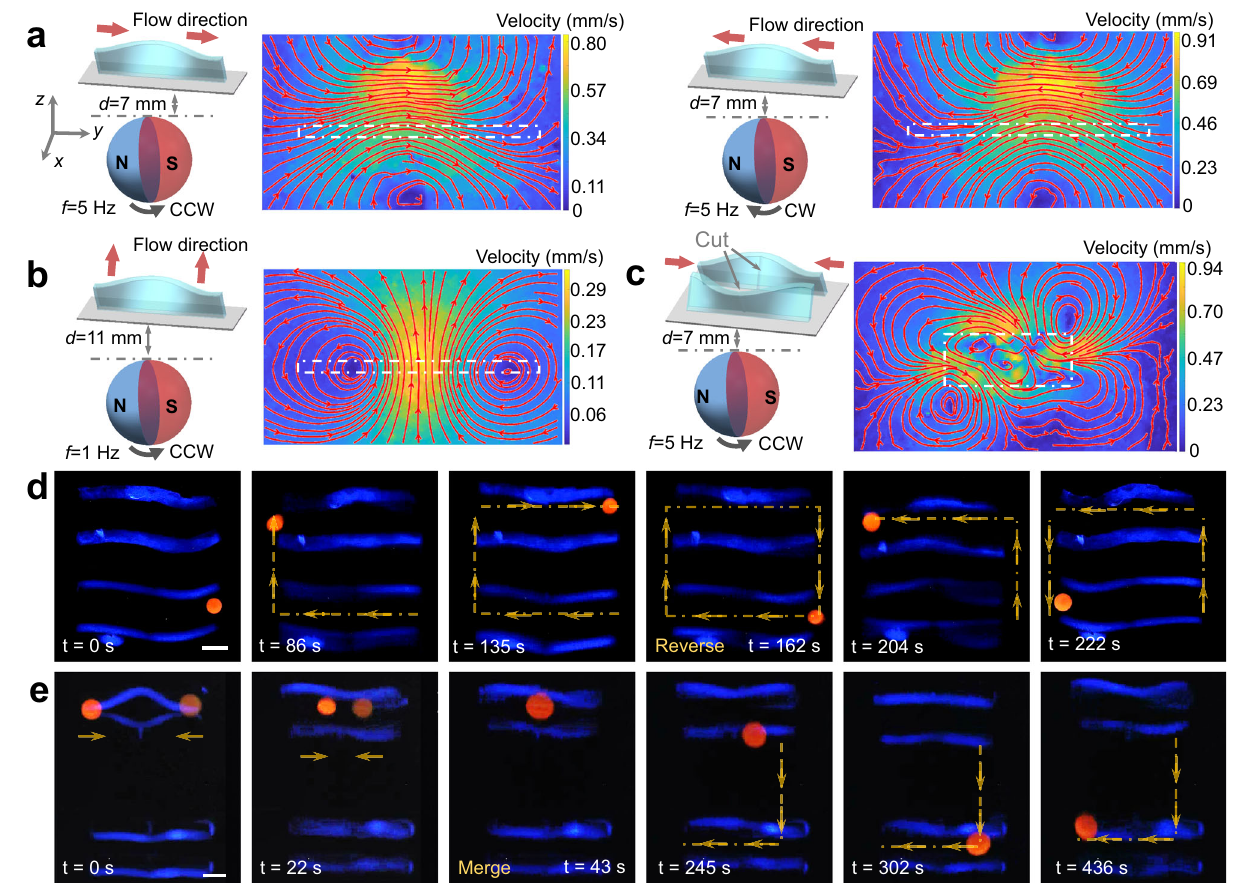
Fig. 6 | Dynamic fl ow fi eld generated by the dynamic transformation of the strip structures. a , b Flow fi eld induced by single strip structure under different magnetic fi eld strength and rotating direction. c Flow fi eld induced by two strip structures with symmetric shape-morphing results, which are induced by sym- metric cuts arranged in strip structures. d , e Demonstration of droplet manipula- tion with the dynamic fl ow fi eld generated by the multiple strip structures. d The droplet reversibly completes a rectangular trajectory via the trip arrays, which